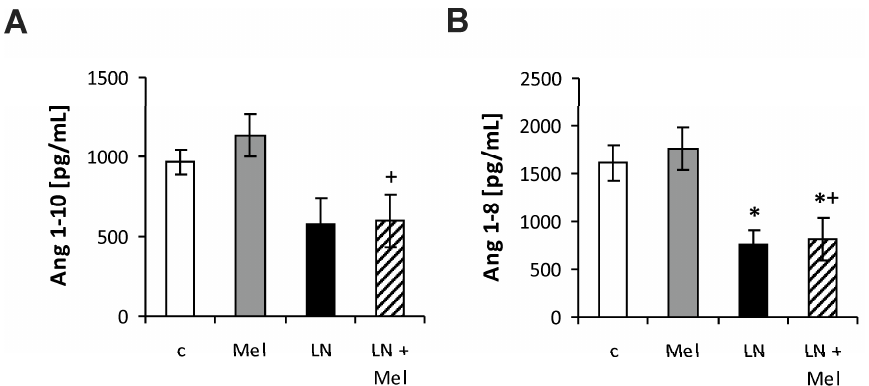
Figure 4. The influence of melatonin (LN + Mel) on the serum level of angiotensin 1–10 (Ang I) ( A ); angiotensin 1–8 (Ang II) ( B ). Wistar controls (c); L -NAME (LN); melatonin (Mel); n = 6 per group; * p < 0.05 vs. c; + p < 0.05 vs. Mel.